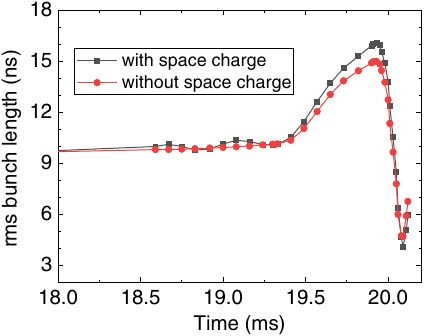
FIG. 11. Simulation results about the effect of space charge on the bunch length during the bunch stretching and bunch rotation processes. Simulation conditions: beam power of 30 kW and chopping factor of